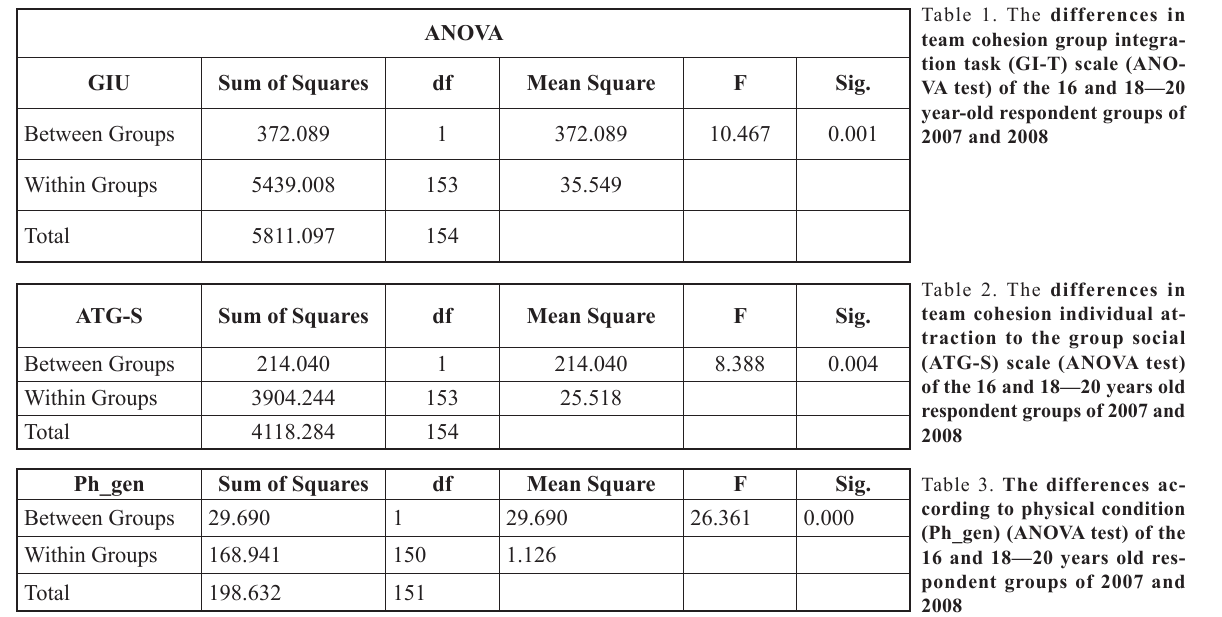
Table 3. The differences ac- cording to physical